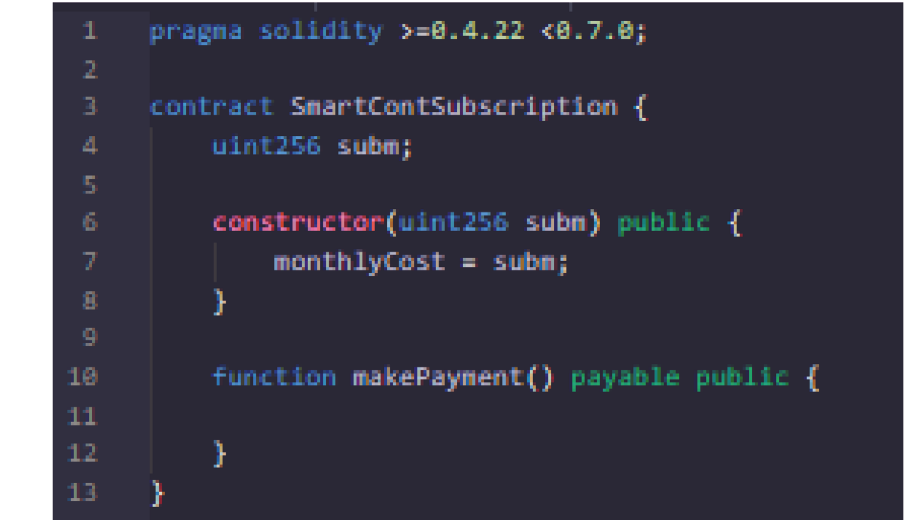
Figure 7: Example of